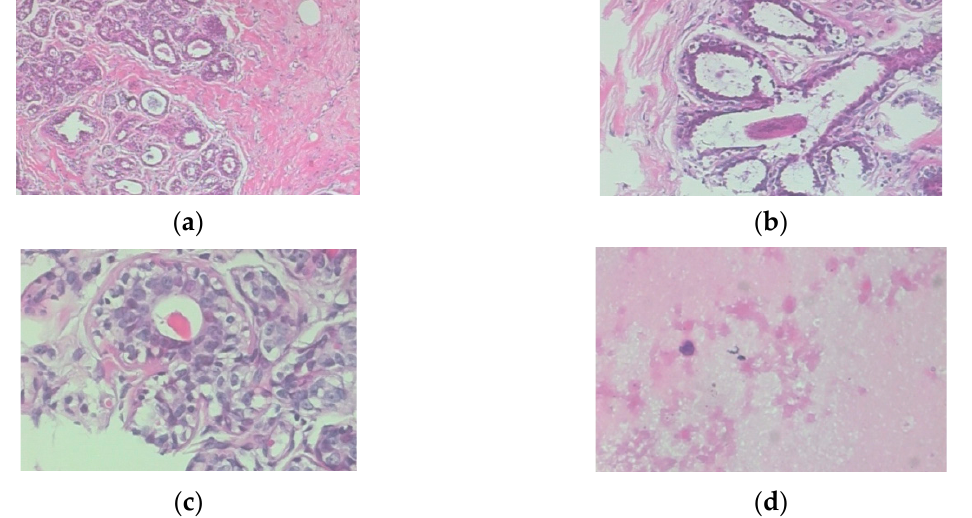
Figure 2. ( a ) Histopathological breast cancer images of the BreakHis dataset: ( a ) 40×; ( b ) 100×; ( c ) 200×; ( d ) 400×.